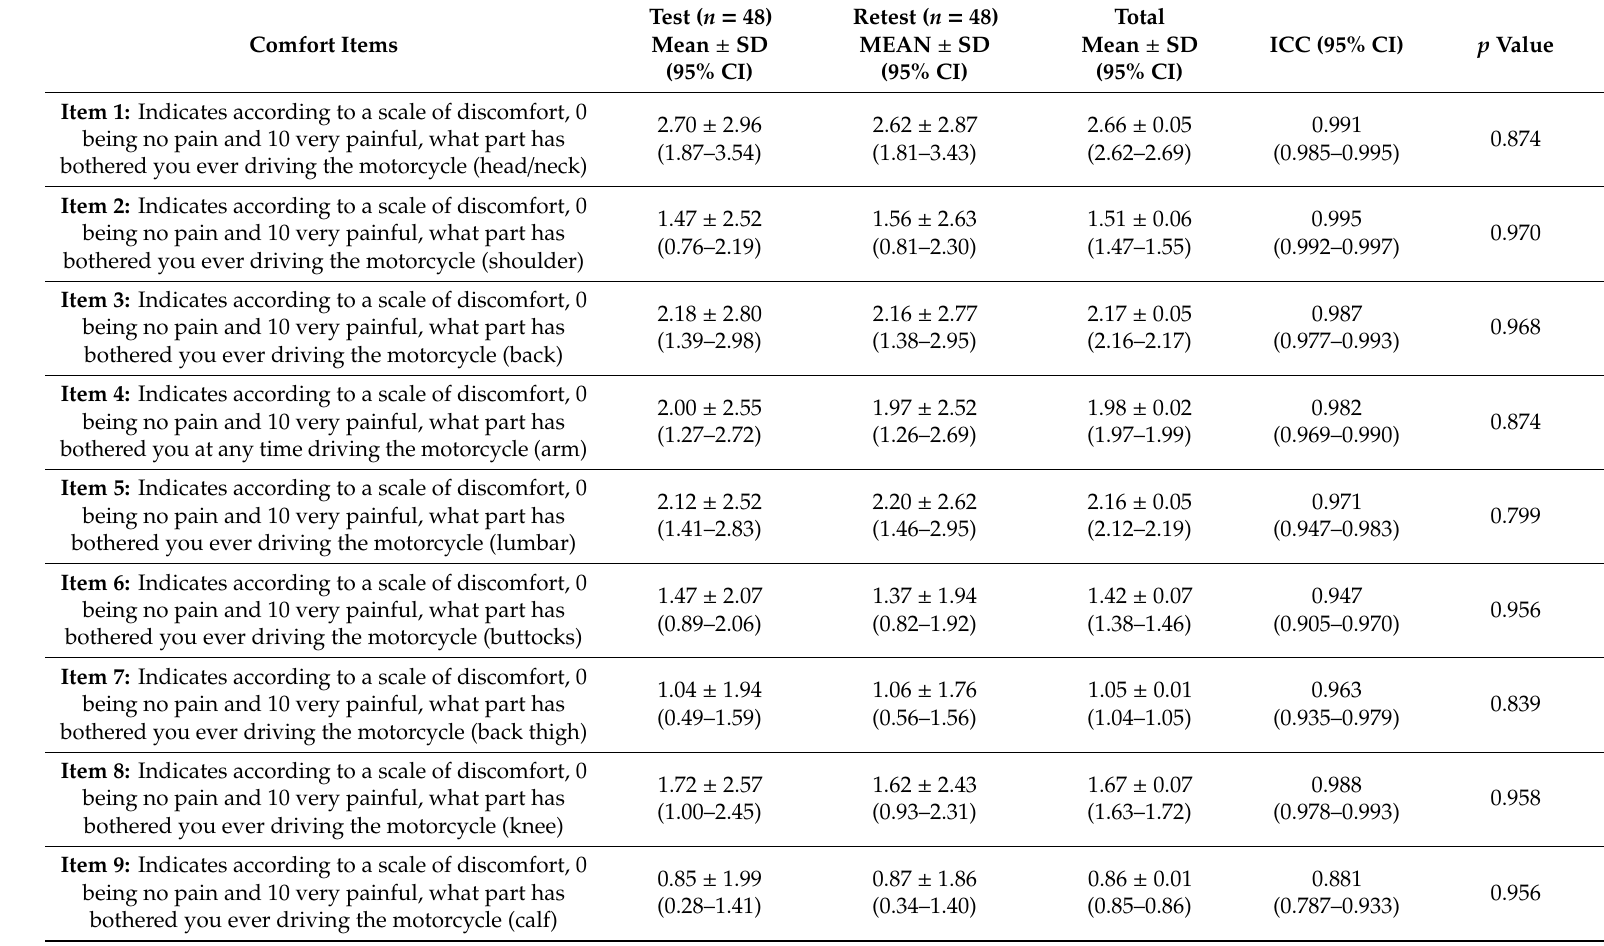
Table 3. Results of reliability, test-retest, and systematic di ff erences of the Spanish of performance and discomfort in the motorcycle driving questionnaire according to each